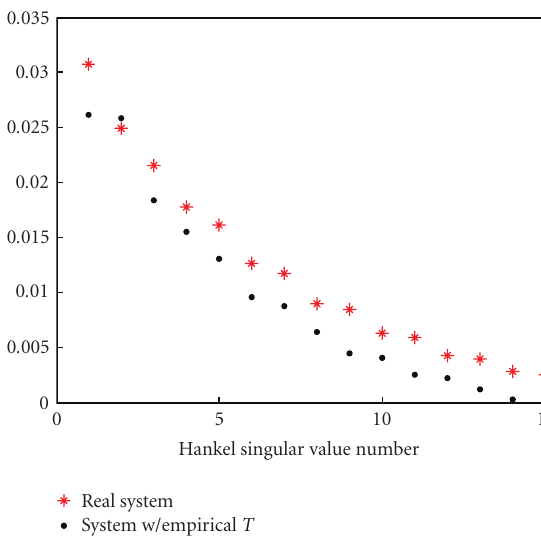
Figure 7: Comparison of Hankel singular values.